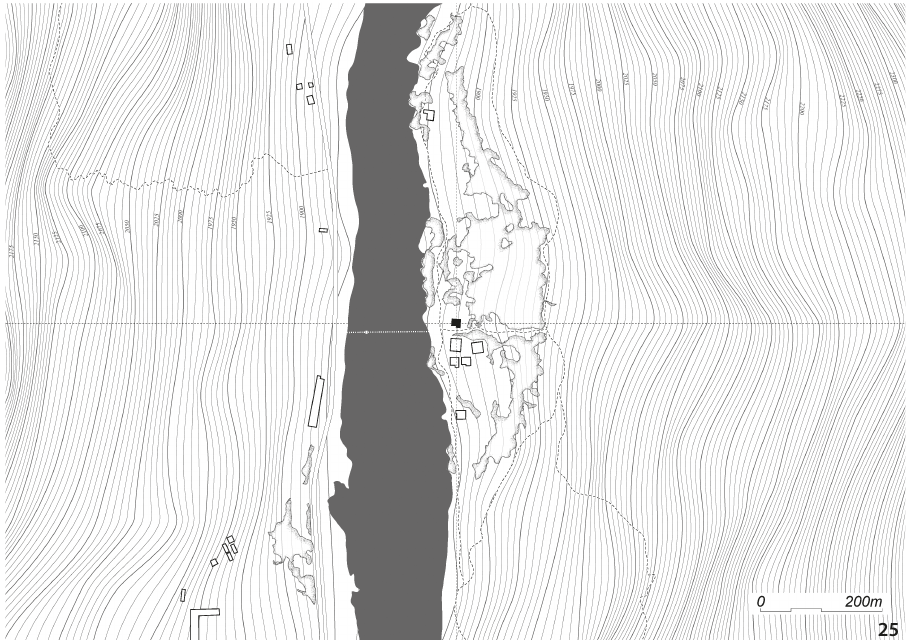
Figure 25 Site plan of the farm- house in Gyalrong (Source: the 25